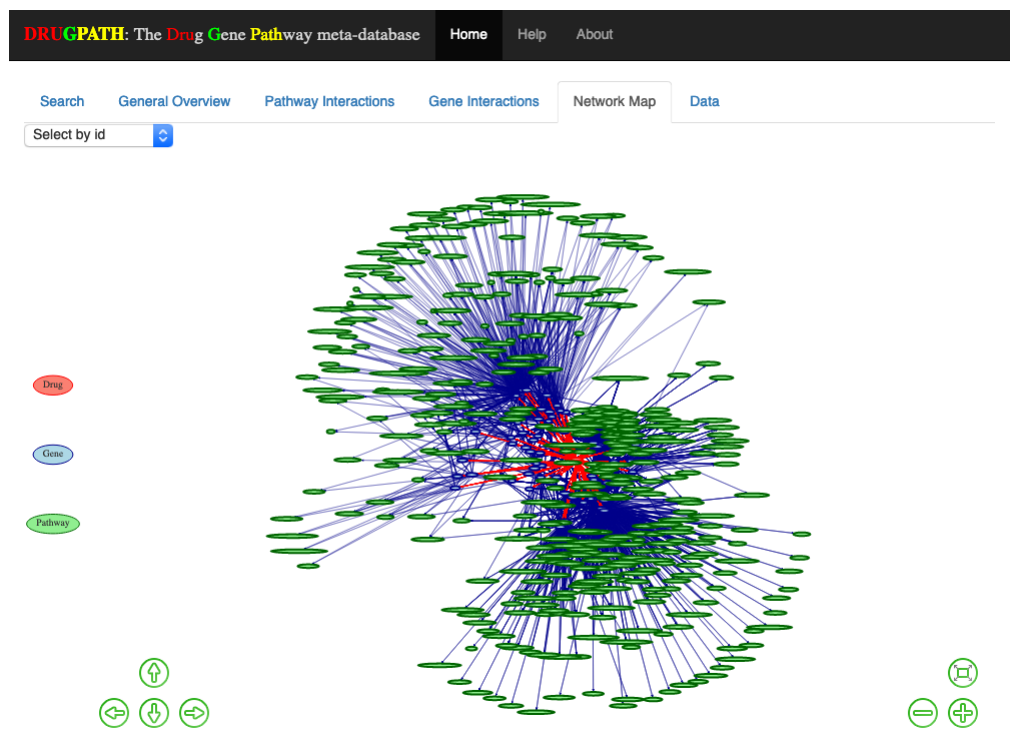
Figure 4. Overview of all the genes and pathways associated with citalopram and phenelzine.